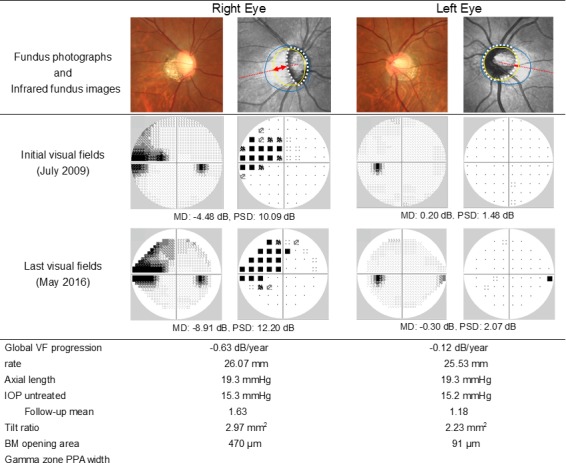
A representative case with a different amount of myopic deformation of the optic discs between paired eyes.Yellow lines in the infrared fundus images indicate BM openings, and white dotted lines delineate the optic disc margins. Red arrows indicate the width of gamma zone PPA along the red dotted lines connecting the fovea and the center of the optic disc. Blue lines delineate the beta zone PPA margins. Humphrey VF data are shown in gray scale and pattern deviation plot.